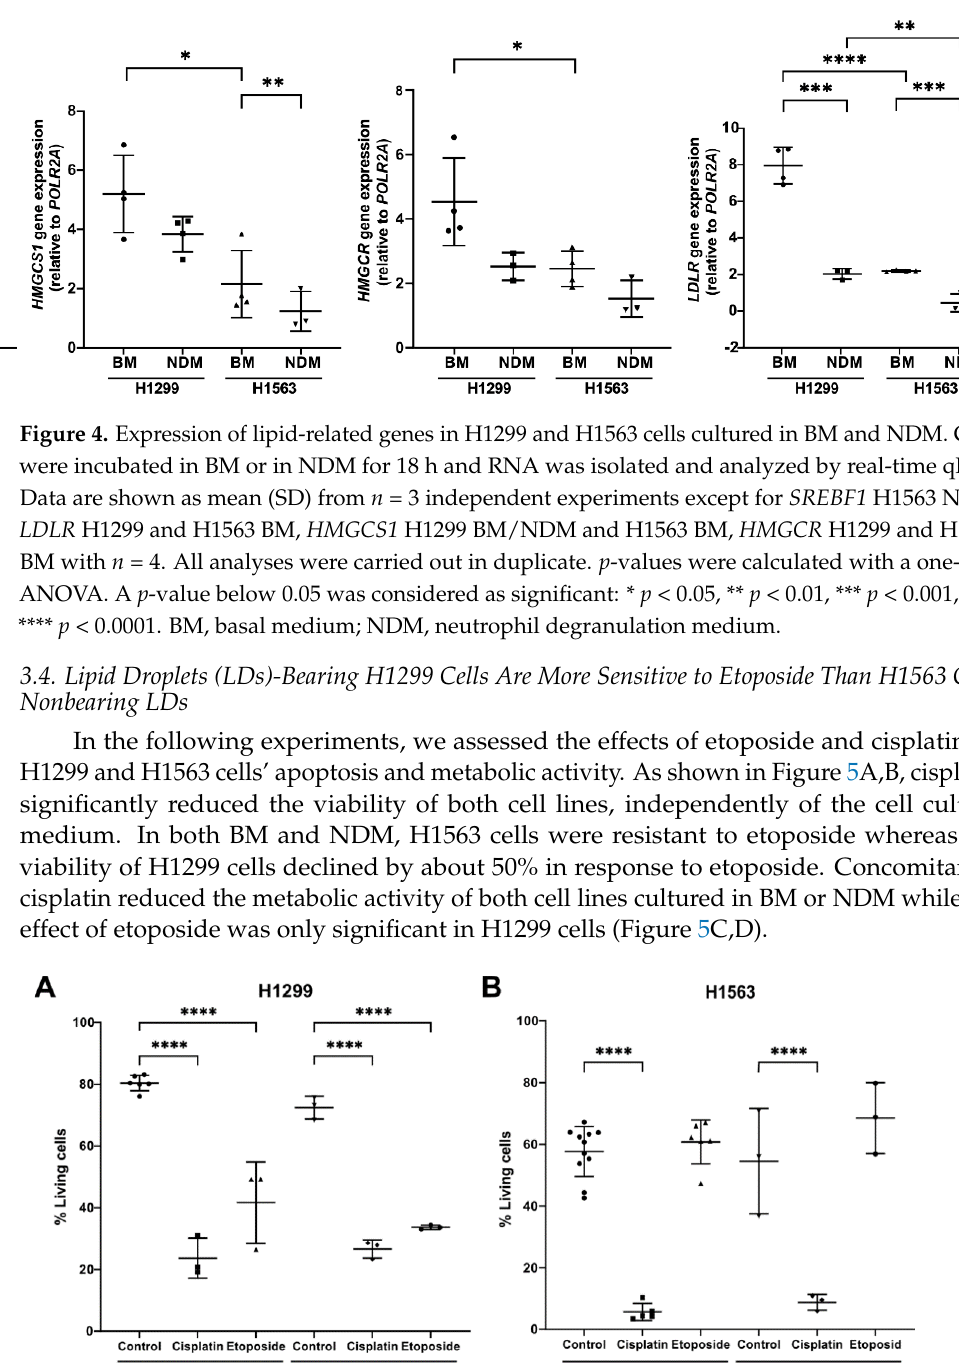
Figure 5. Effects of cisplatin and etoposide on cell viability and metabolic activity in BM and NDM. Cells were cultured for 48 h in BM or NDM in presence or absence of 20 μg /mL cisplatin or 100 µM etoposide. Cell viability analysis by Annexin V 7AAD Apoptosis Detection Kit for H1299 cells ( A ) or H1563 cells ( B ). Livings cells (%) were determined against nontreated controls for each medium separately. p -values of treatment vs. control were calculated with a one-way ANOVA. Data are pre- sented as mean (SD). A p -value below 0.05 was considered as significant. **** p < 0.0001. n = 3 for cell viability (except H1563 BM: n = 5). ( C , D ). Cell metabolic activity assay for H1299 ( C ) and H1563 ( D ) cells. ( C ) Data are presented as mean (SD) and p -values calculated with a one-way-ANOVA and ( D ) data presented as median (IQR) and p -values calculated with a Kruskal – Wallis test. A p -value below 0.05 was considered significant. * p < 0.05, ** p < 0.01, *** p < 0.001, **** p < 0.0001, n = 6; BM, basal medium; NDM, neutrophil degranulation medium. 3.5. Cisplatin and Etoposide Induce LD Formation in H1563 Cells but Do Not Affect LD in H1299 Cells It is known that chemotherapies can interfere with LD formation [30], therefore we investigated LDs in cancer cells treated with etoposide or cisplatin for 48 h As illustrated in Figure 6A,C, H1299, but not H1563, cells formed LDs in BM. Treatments with cisplatin or etoposide had no effect on LD formation in H1299, however, they induced LDs in H1563 cells (Figure 6C). The same scenario was observed when cells were cultured in NDM (data not shown). The quantification of the LDs did not show significant differences between H1299 treated or not treated (Figure 6A,B), while in H1563 cells, the drugs in- duced LDs (Figure 6C,D). As expected, higher levels of SREBF1 mRNA and protein were found in H1299 cells forming LDs than in H1563 cells without LDs (Figure 7A,B). Although chemotherapeutics reduced SREBF1 gene expression in both cell lines, this reduction did not parallel with